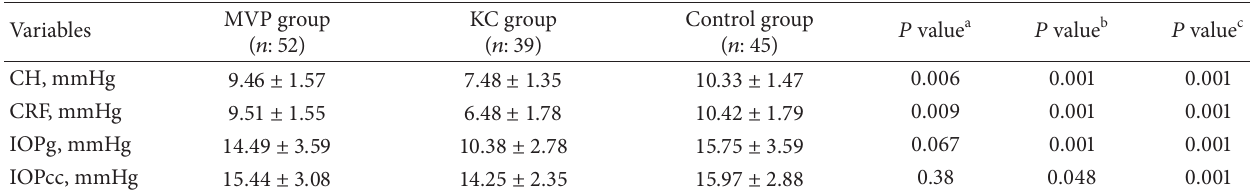
Table 2: Corneal biomechanical properties of the patients and the control